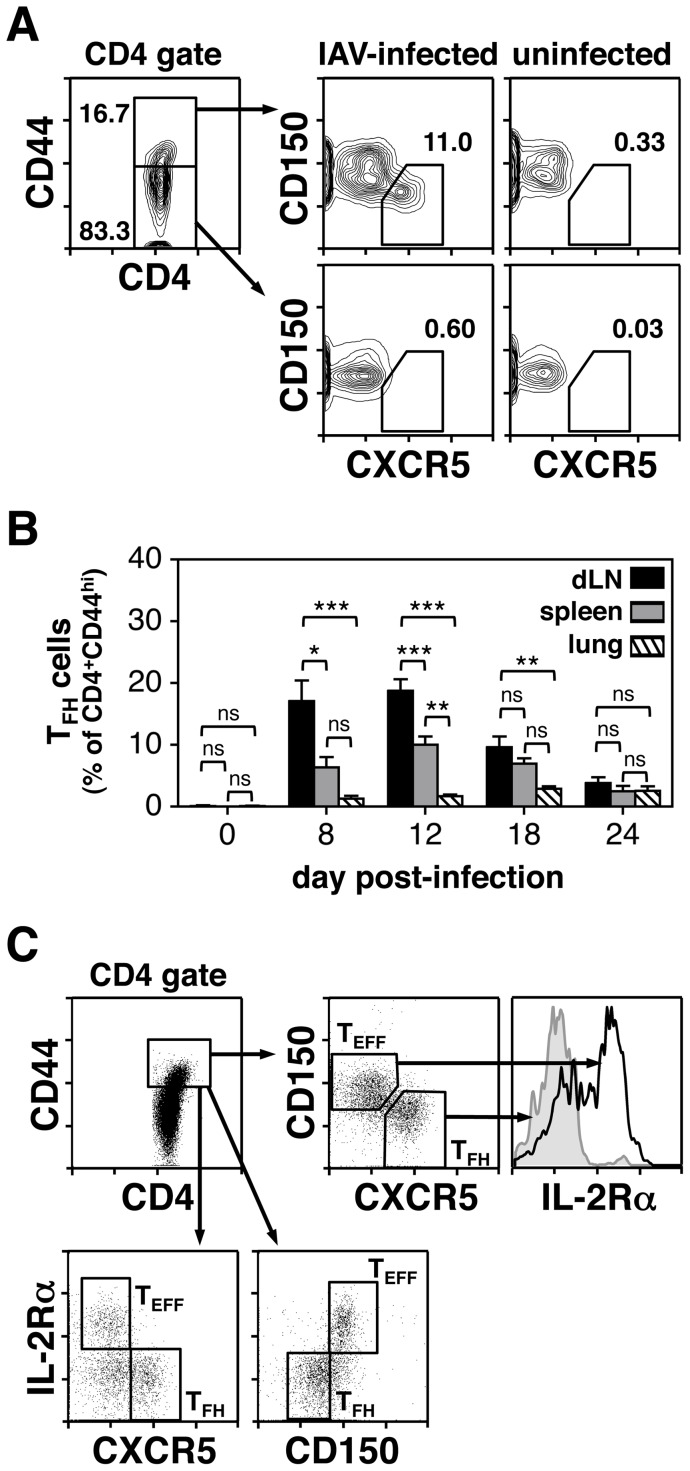
TFH cell populations are induced upon IAV infection.Animals were infected i.n. with a 0.1LD50 dose of IAV on day 0. dLNs, lung, and spleen were harvested on days 8–24 post-infection and stained with anti-CD4, anti-CD44, anti-CXCR5 and anti-CD150 mAbs. Tissues from uninfected animals were also analyzed and are shown as day 0. A) Representative plots show the gating strategy used to define CD4+CD44hi CXCR5+CD150lo TFH cells. The value next to each gate represents the individual percentage from that sample. B) Bar graphs represent the percent of CXCR5+CD150lo TFH cells within the CD4+CD44hi population from dLNs, spleen, and lung. Each bar represents mean ± SEM. n = 5–6 mice for infected mice. n = 3 for uninfected mice. ns = not significant; *p<0.05; **p<0.01; ***p<0.001; determined with the ANOVA test. C) Animals were infected i.n. with a 0.1LD50 dose of IAV on day 0. dLNs were harvested on day 12 post-infection and stained with anti-CD4, anti-CD44, anti-CXCR5, anti-CD150 and anti-IL-2Rα (CD25) mAbs. Representative plots demonstrate the presence of IL-2Rαhi TEFF cells within the CD4+CD44hiCXCR5−CD150hi population. IL-2Rαhi T cells are nearly absent in the CD4+CD44hiCXCR5+CD150lo TFH gate.